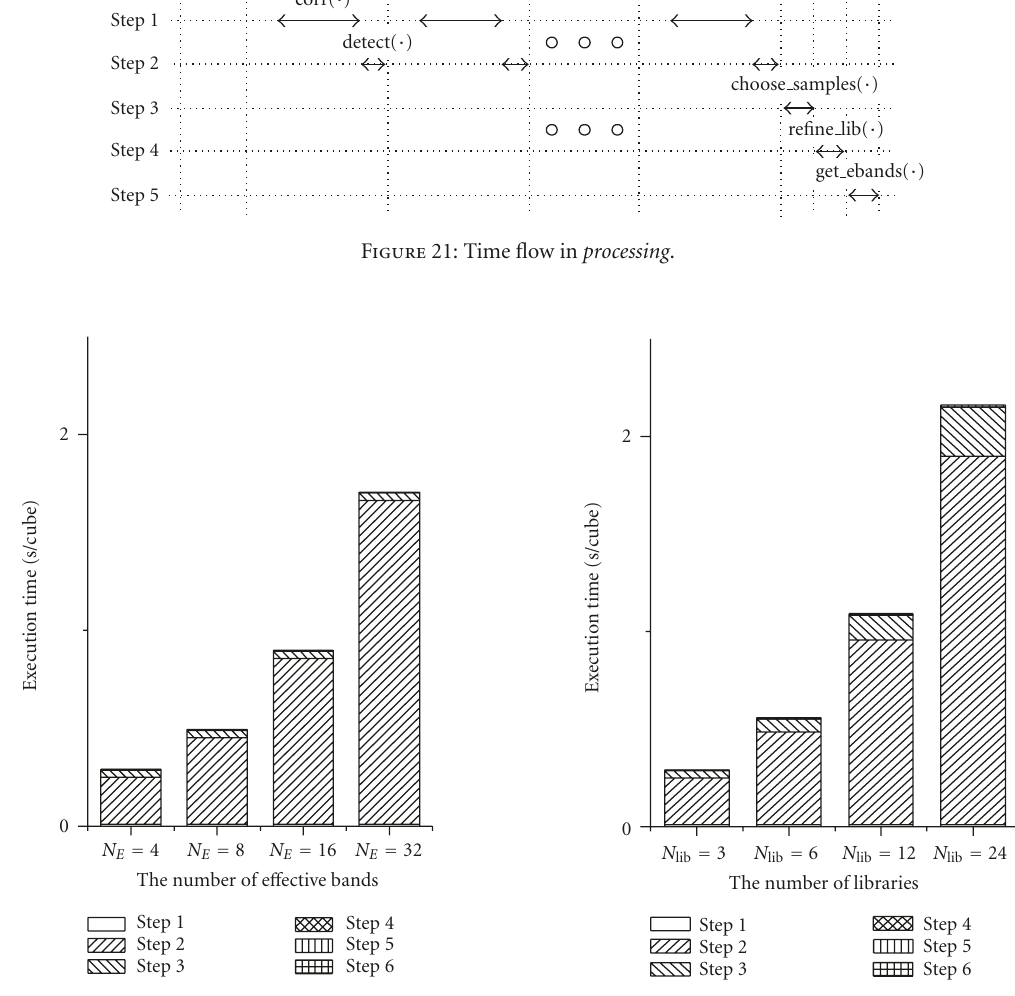
Figure 22: The execution time in function of number of e ff ective bands and the number of libraries, where (a) N lib = 3, N x = 820, N y = 748, N N N N N N N B = 1000, T = 1000; (b) E = 4, x = 820, y = 748, B = 1000, T =